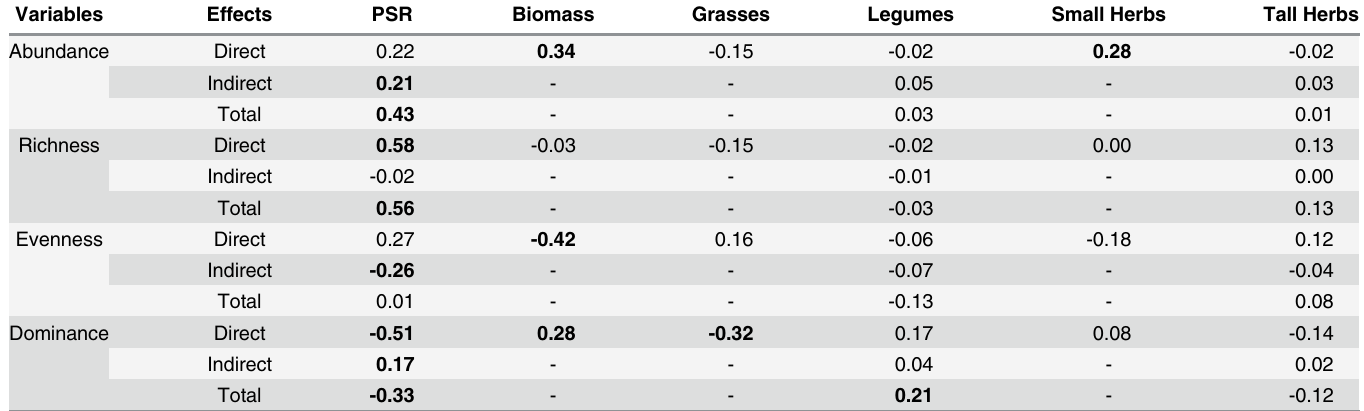
Table 1. Standardized SEM coefficients for herbivore diversity indices. Direct, indirect and total effects of plant species richness (PSR) on herbivore abundance, species richness, shannon evenness and dominance. Indirect effects are computed as the product of the PSR effect on plant biomass and the plant biomass effect on the diversity indices. Total effects are the sum of direct and indirect effects. Reported are also the effects of the four plant functional groups (Grasses, Legumes, Small Herbs and Tall Herbs). Coefficients in bold indicate a p-value < 0.05.